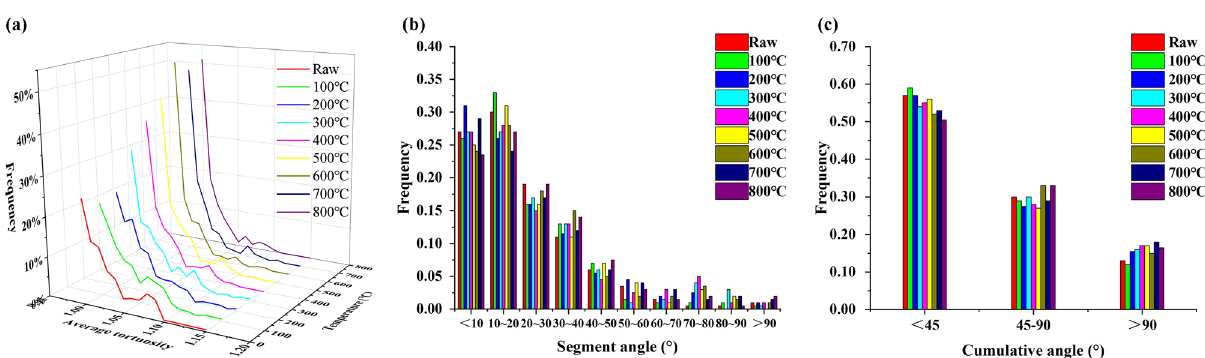
Figure 5. Degree of curve of lattice fringe of heat treatments. ( a : Average tortuosity; b : Segment angle; c : Cumulative